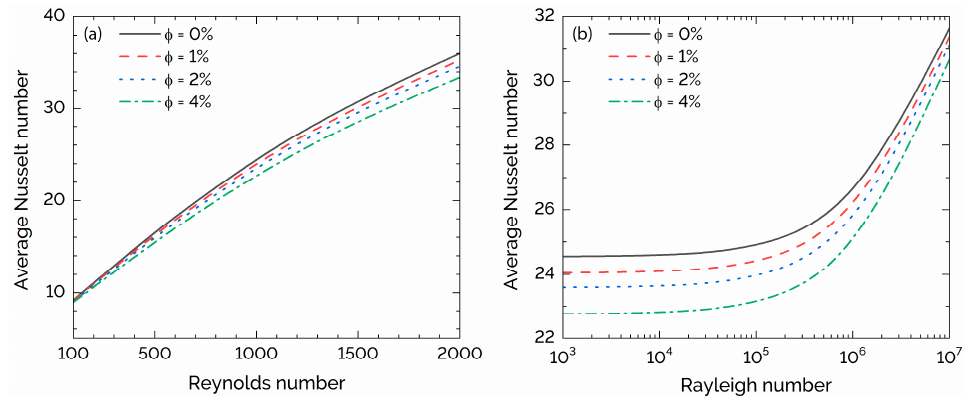
Figure 7. Effects of the concentration of CuO-nanoparticles on Nu avg for four values of particle concentrations. ( a ) Reynolds number and ( b ) Rayleigh number.